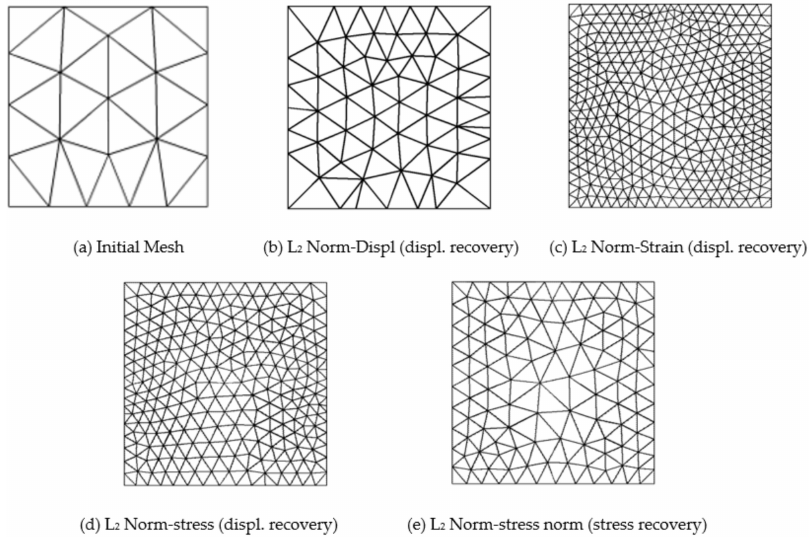
Figure 5. Adaptive mesh required for 1% target error (L 2 -Norm) in compressible elastic square plate example solution variables considering displacement and stress recovery techniques (Initial regular quadratic triangular mesh: N = 28, DOF =